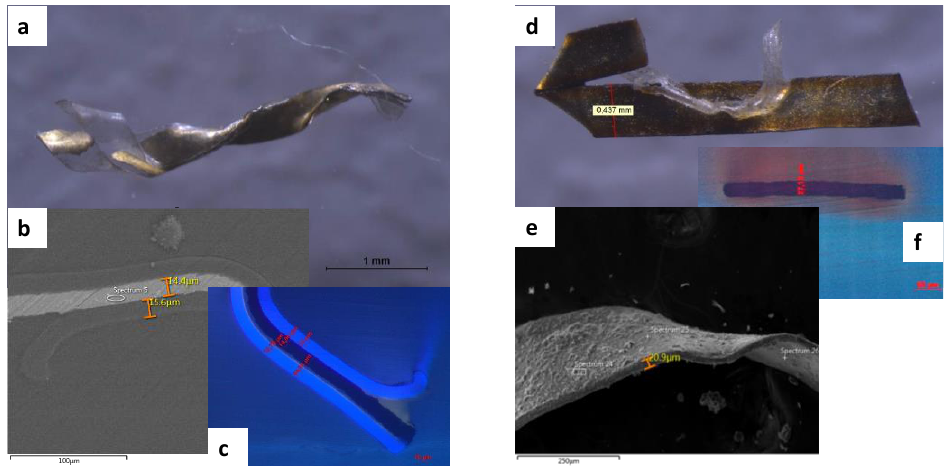
Figure 4. Different types of metal threads: ( a ) photograph of sample C10 under the optical microscope, 18 × ; ( b ) SEM image of the cross section of sample C10; ( c ) photograph under UV light of the cross section of sample C10, 20 × ; ( d ) photograph of sample C14 under the optical microscope, 18 × ; ( e ) SEM image of a side view of sample C14; ( f ) photograph under UV light of the cross section of sample C14, 10 ×